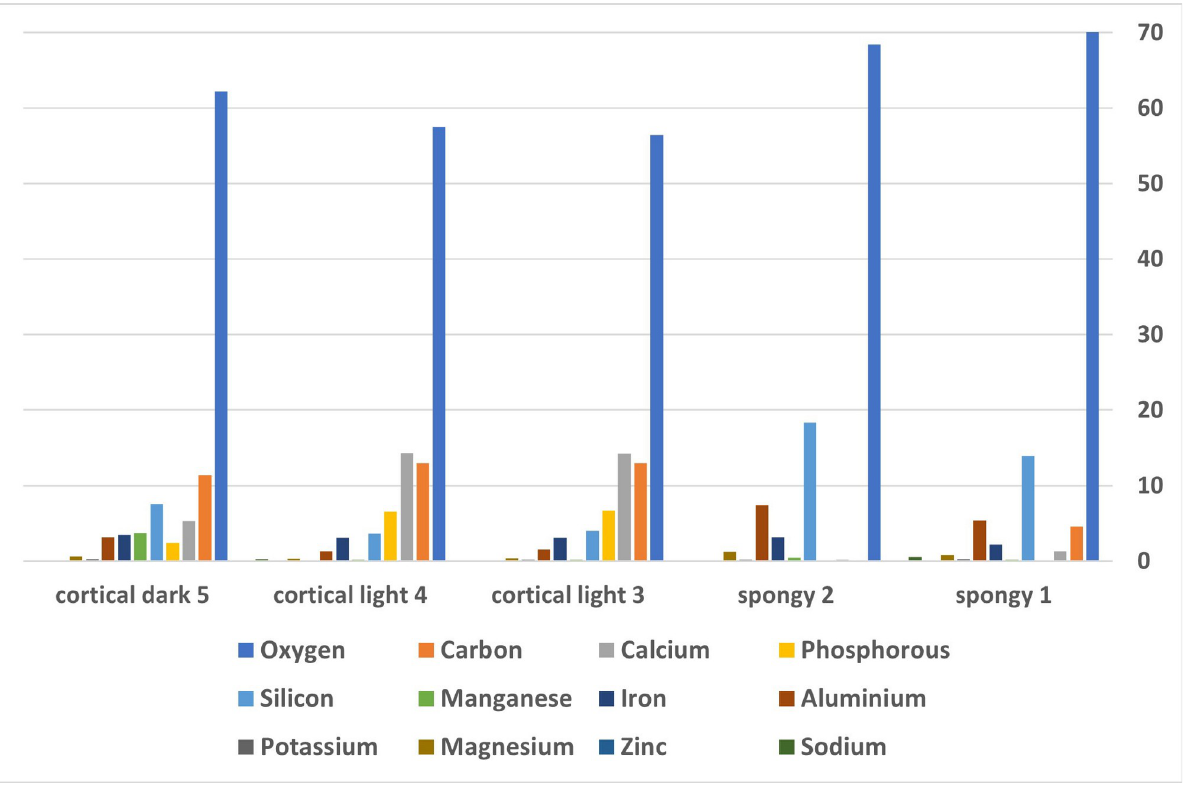
Fig 14. Elemental composition of four bones given as atomic